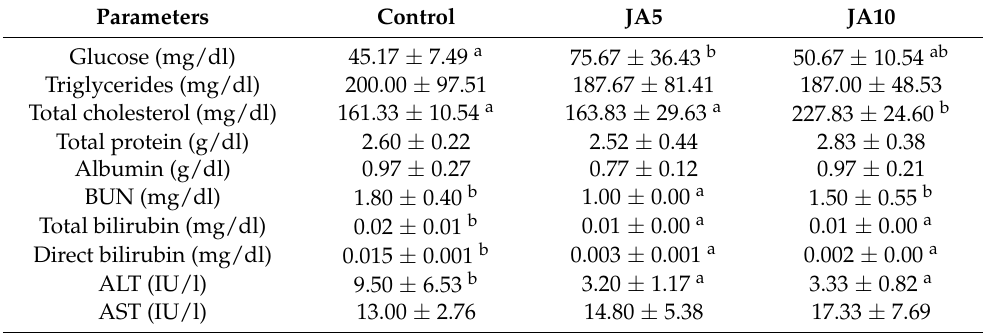
Table 3. Blood serum biochemical parameters of red tilapia fed experimental diets for 4 weeks. Parameters